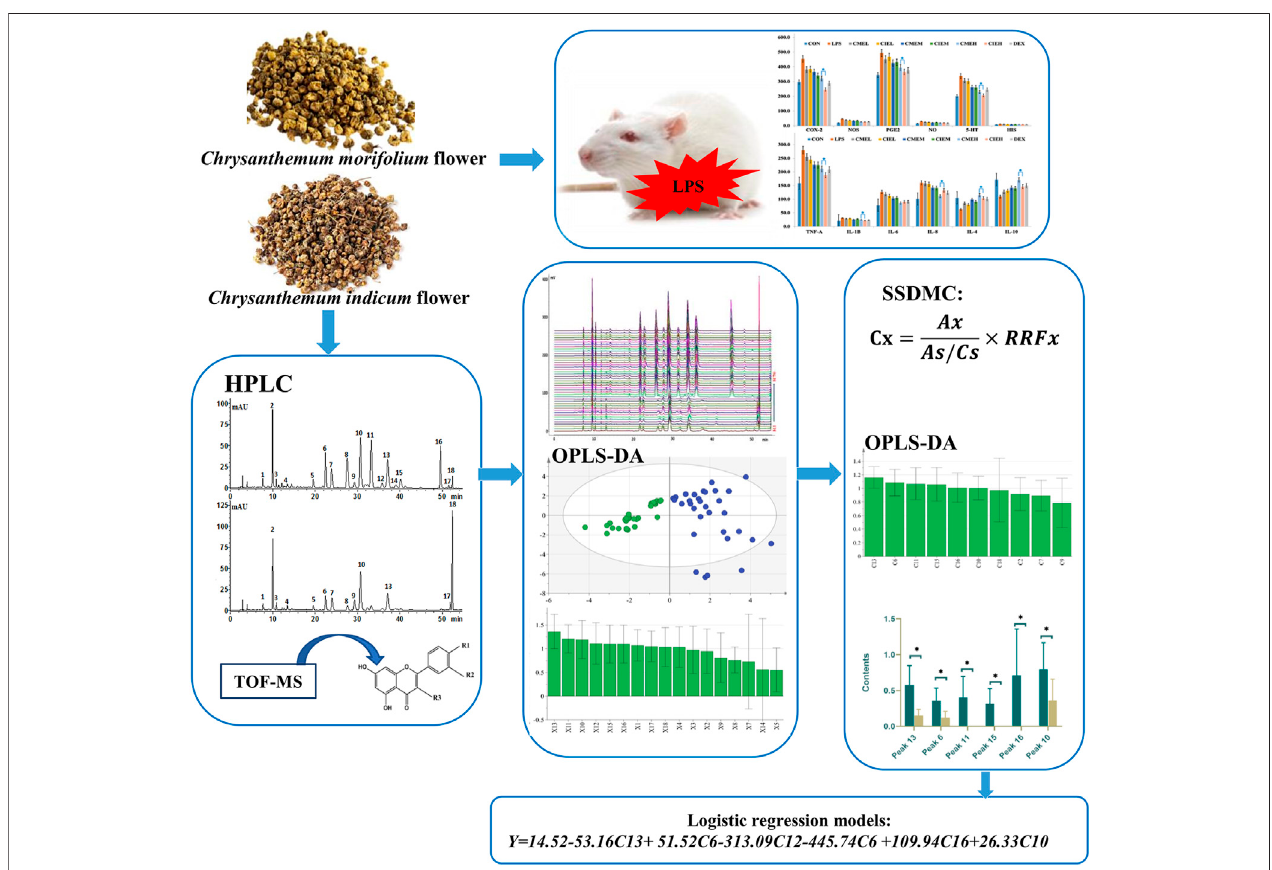
FIGURE 2 | The graphic workflow of the